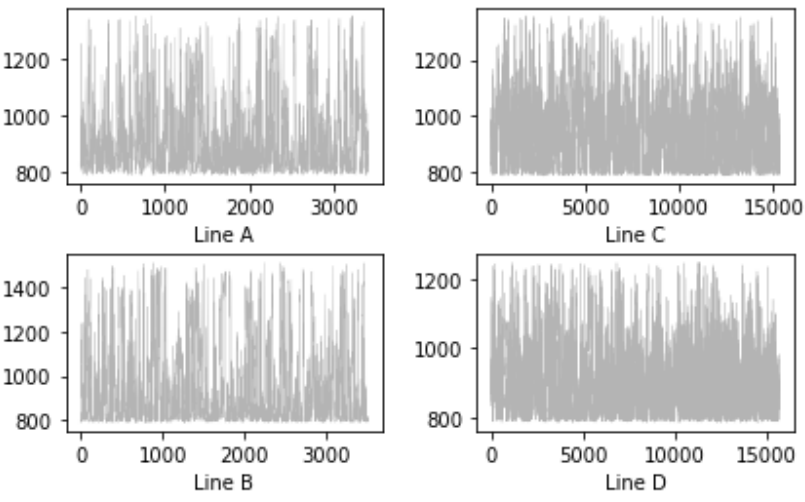
Figure 4. Cycle time per line (in seconds), without outliers .